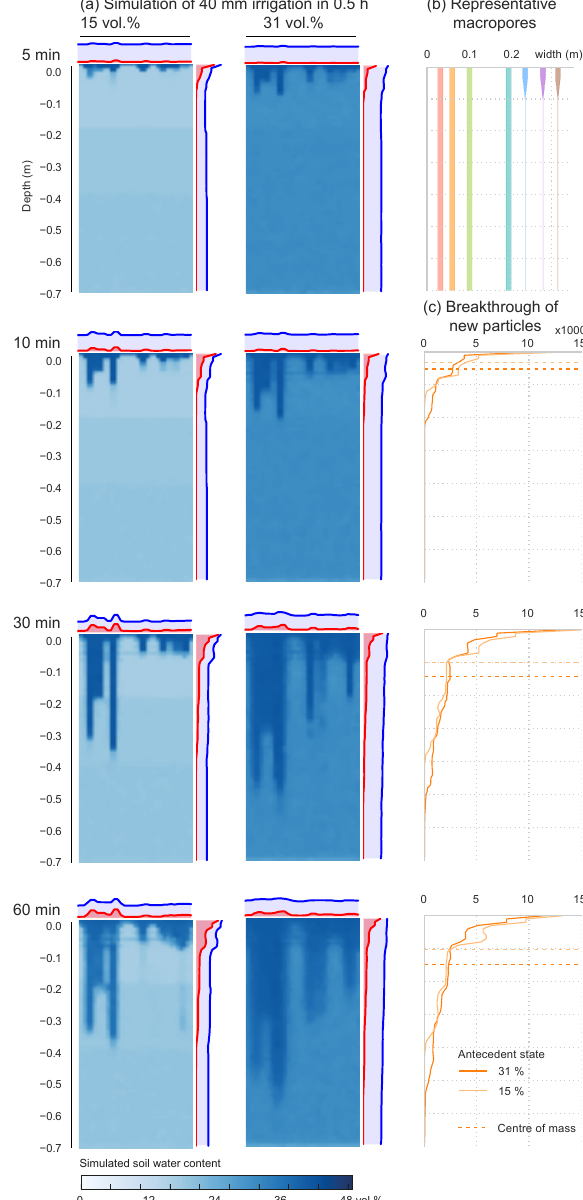
Figure 5. Simulated soil moisture dynamics in generic application tests of loess soil. The marginal plots give the distribution of all particles (blue) and newly infiltrated particles (red). (b) The defini- tion of the representative macropore domain. (c) The breakthrough curves of new particles at the different time steps for the two an- tecedent